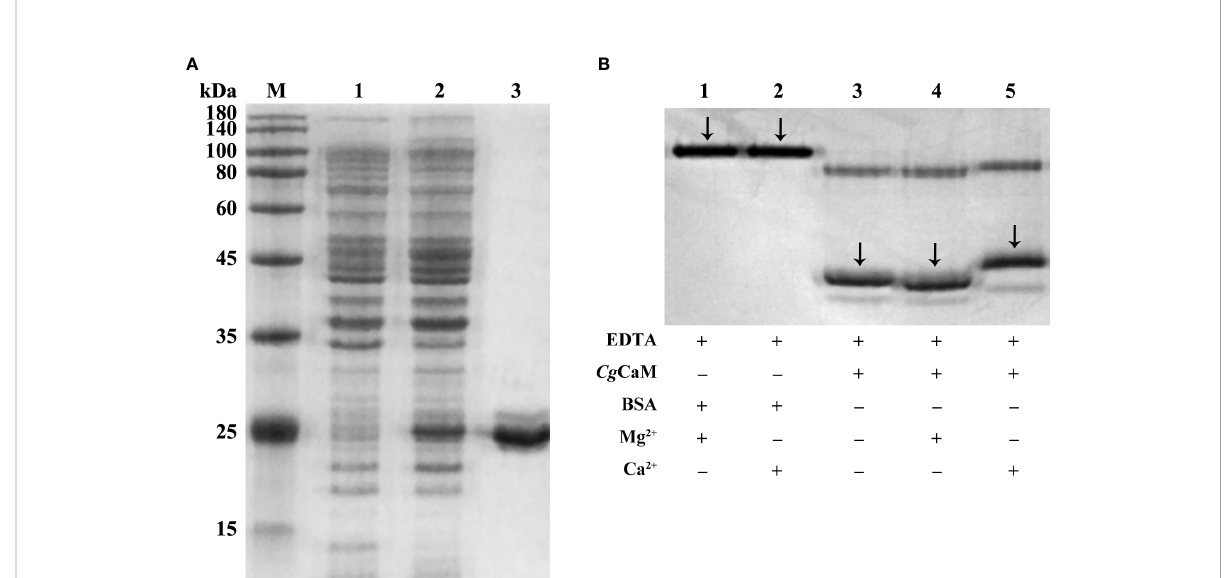
FIGURE 5 (A) SDS-PAGE analysis of r Cg CaM. Lane M: protein molecular standard (kDa); Lane 1: negative control without IPTG induction; Lane 2: positive transformant induced by IPTG; Lane 3: puri fi ed r Cg CaM. (B) Ca 2+ -dependent electrophoretic migration analysis of puri fi ed r Cg CaM. Lane 1: BSA + 20